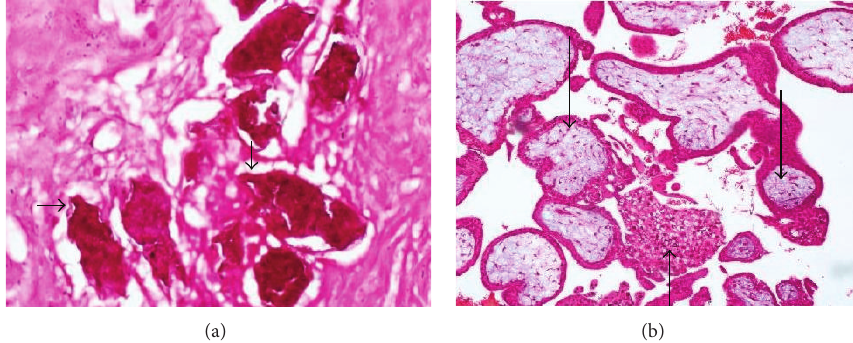
Figure 5: Photomicrographs showing S. haematobium ova with characteristic terminal spines (short arrows), granuloma (medium arrow), and chorionic villi in the left tube (long